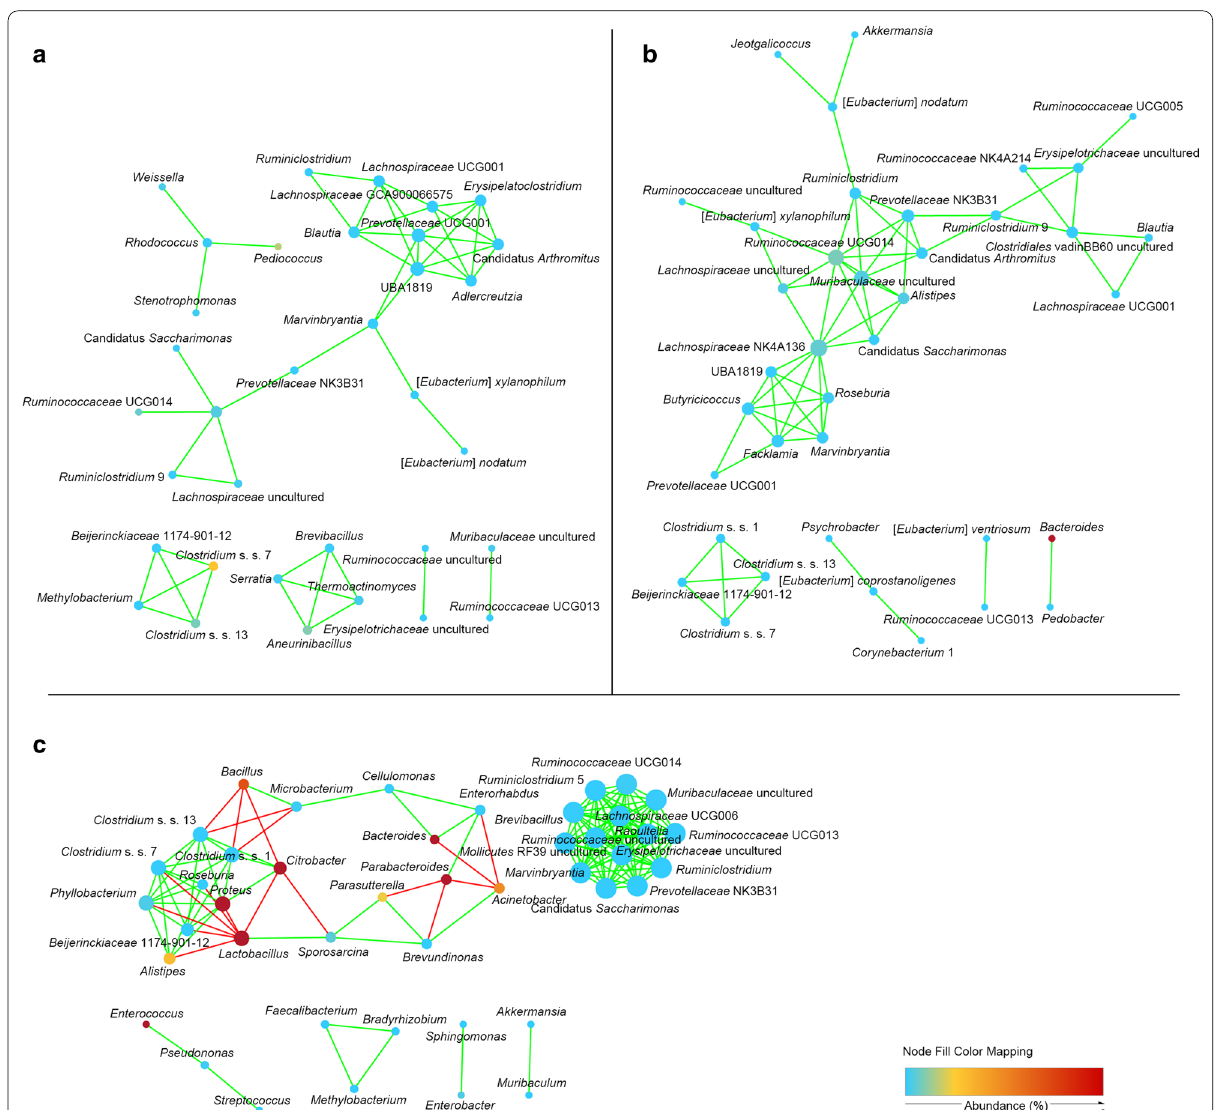
Fig. 4 Network analysis indicating interactions among the genera in the low- ( a ), moderate- ( b ), and high-density groups ( c ). Each node is a bacterial genus, and the edges indicate significant co-occurrent (green) or mutual exclusion (red) interactions